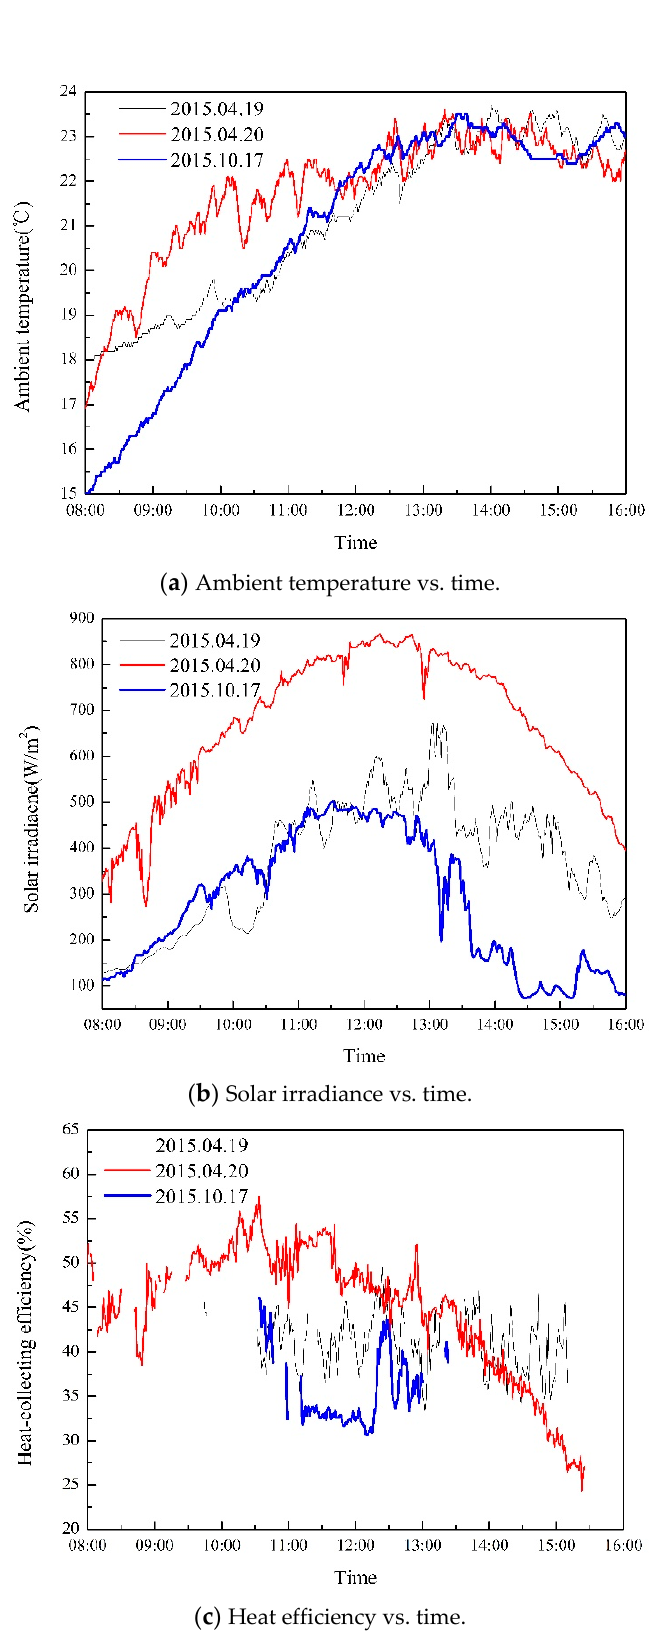
Figure 3. The relationship among solar irradiance, ambient temperatures, and thermal efficiency.